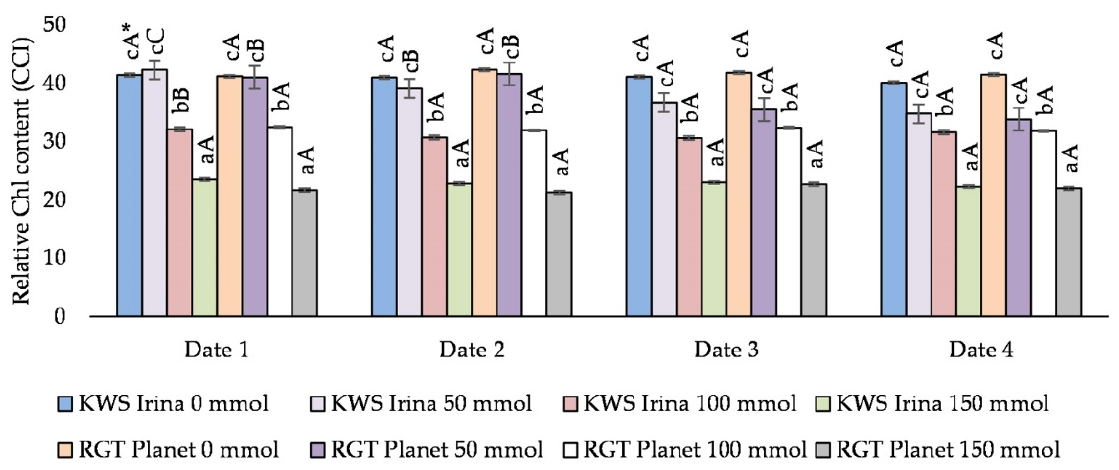
Figure 1. The effect of the NaCl (mmol NaCl (dm 3 ) − 1 ) concentration and measurement date on the chlorophyll content in the leaves (CCI; date 1, 7 days after NaCl application; date 2, 14 days after NaCl application; date 3, 21 days after NaCl application; and date 4, 28 days after NaCl application) * Capital letters indicate significant differences between the means at the measurement dates for particular NaCl concentrations, and lower case letters indicate significant differences between the means at subsequent measurement dates ( p = 0.05).